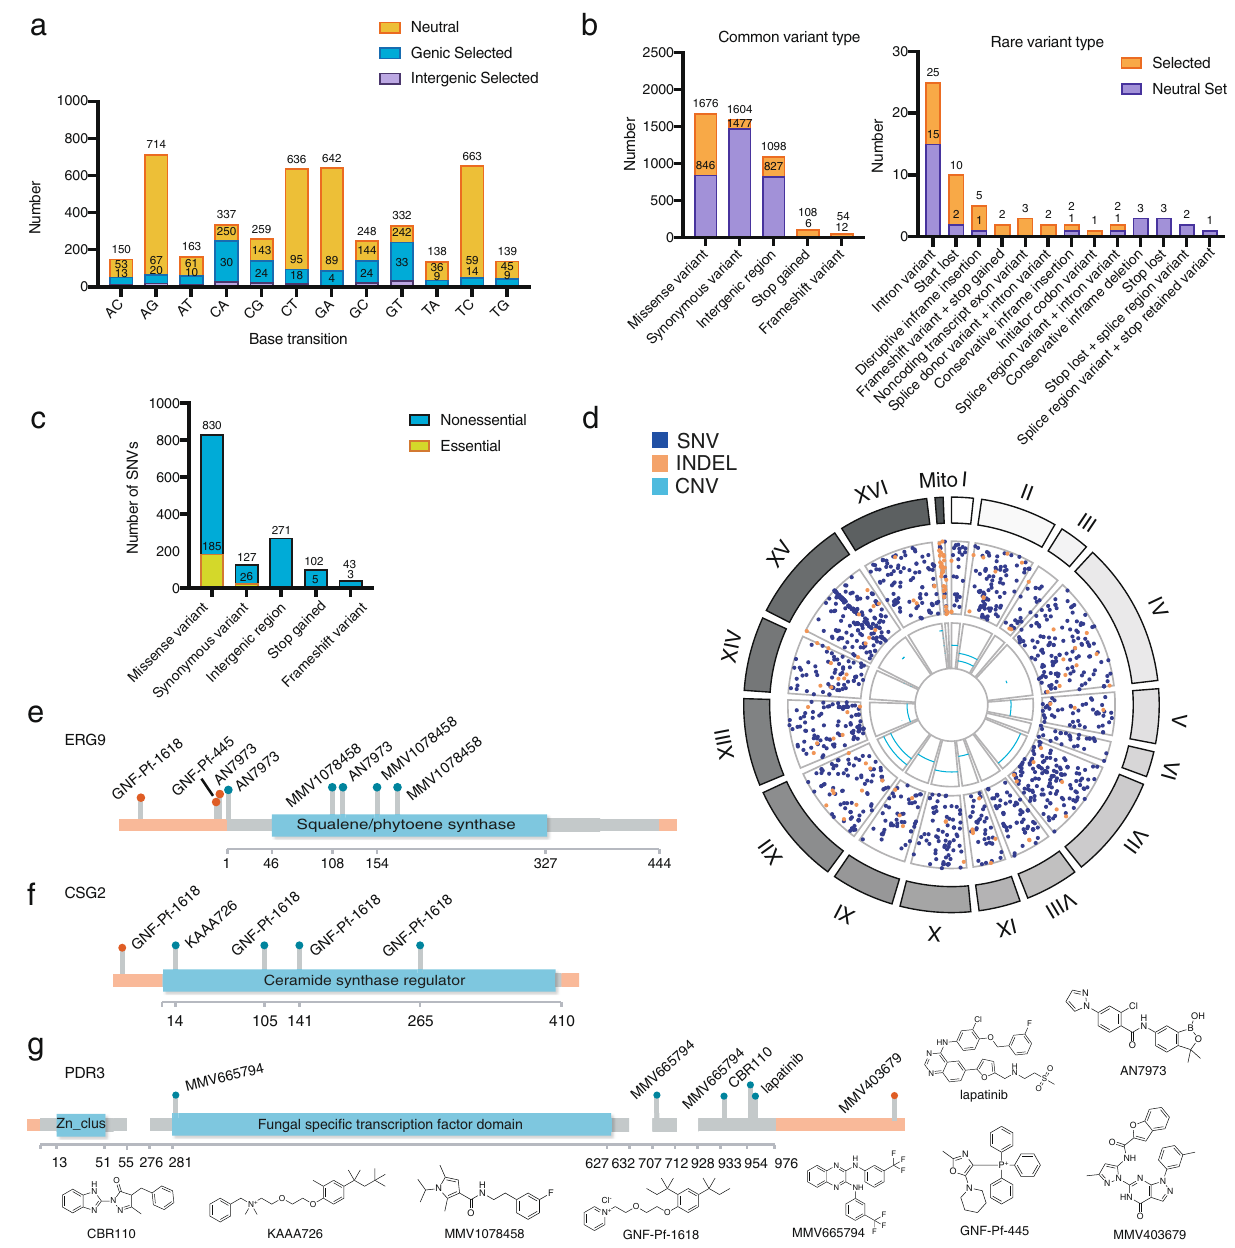
Fig. 3 Mutations observed in yeast IVIEWGA experiments. a Base transition. Classi fi cation of mutation based on base transition type for 1286 SNV mutations obtained via compound selection and absence of compound selection 105 . b Classi fi cation of the most common mutation types in the dataset and their occurrence in essential vs. nonessential genes. Essentiality data were imported from the Saccharomyces Genome Deletion Project database and proportion of essential vs. nonessential genes that contained missense, synonymous, frameshift, and stop gained mutations were calculated. c Mutation type. Variant classes for 1405 mutations (INDELs and SNVs supplied from Supplementary Data 4) obtained via compound selection versus a mutation dataset from non-compound selection conditions 105 . d Circos plot. Circos plot of SNVs (blue), INDELs (orange), and CNVs (cyan) identi fi ed through resistance generation, generated with BioCircos R package 106 . e – g Intergenic mutations. Plot locating each coding region mutation onto the gene (gray) and intergenic mutation onto the chromosome (orange) based on the calculated distance. Mutations were mapped to their corresponding genomic location using S. cerevisiae S288C genome version R64-2-1. Intergenic mutations are located at no more than 500 bp away from the start/end of the